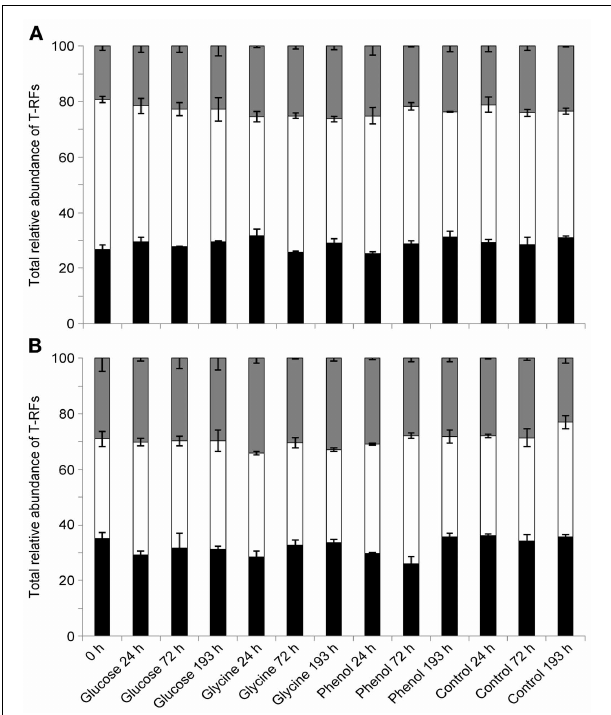
FIGURE 4 | Differences in substrate 13 C utilisation in vegetated and bare soils. Mean assimilation of glucose, glycine and phenol 13 C into RNA extracted from soil ( μ g 13 C μ g − 1 RNA) (A) . Glucose 13 C incorporation was greater than the other FOC additions, although there were no consistent effects between vegetated and bare soils. Mean FOC use efficiency, displayed as the ratio of RNA 13 C incorporation to respired substrate (RNA 13 C : 13 CO 2 - C μ gg − 1 dry soil) (B) . FOC was consistently utilised more efficiently in bare soil. Error bars are SEM ( n = 3). Significant differences denoted by ∗